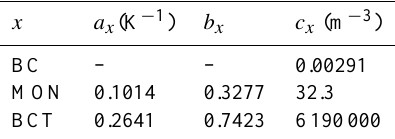
Table 3. Parameters a x and b x for contact freezing (Diehl et al., 2006) and parameter c x for immersion freezing (Diehl and Wurzler, 2004) of black carbon (BC), montmorillonite (MON) and bacteria (BCT).